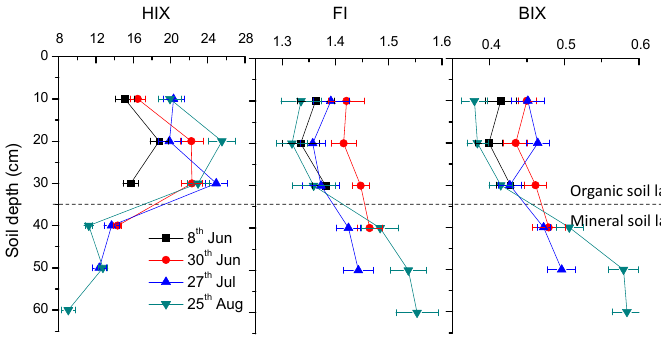
Figure 8. Vertical distribution of the three spectral indices for soil porewater along the soil profile in